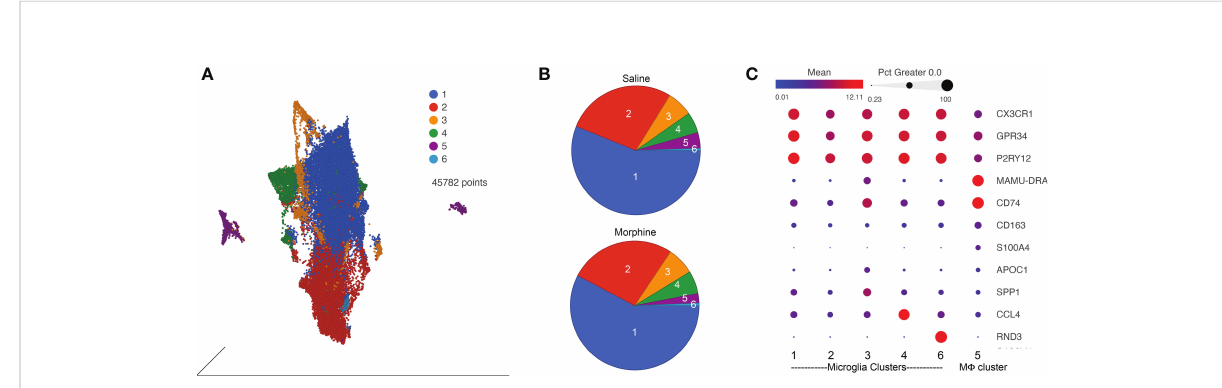
FIGURE 4 ScRNA-seq analysis of brain macrophages and microglia from the saline and morphine groups of animals. (A) Uniform Manifold Approximation and Projection (UMAP) representation of the cells, grouped in 6 clusters and differentially colored as determined by graph-based clustering. (B) Pie charts of the proportion of cells in each cluster for the saline and morphine groups. (C) Bubble plot of selected genes differentiating the clusters. The color indicates the least-square mean expression (log 2 ), and the size of the circle indicates the percentage of cells in which gene expression was detected.